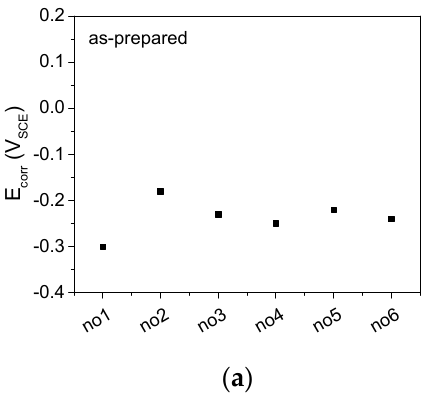
Figure 6. Corrosion potentials of Cu in inhibited antifreeze solutions measured ( a ) with as-prepared Cu specimens and solutions and ( b ) with Cu specimens and solutions used for 3 weeks of immersion test.